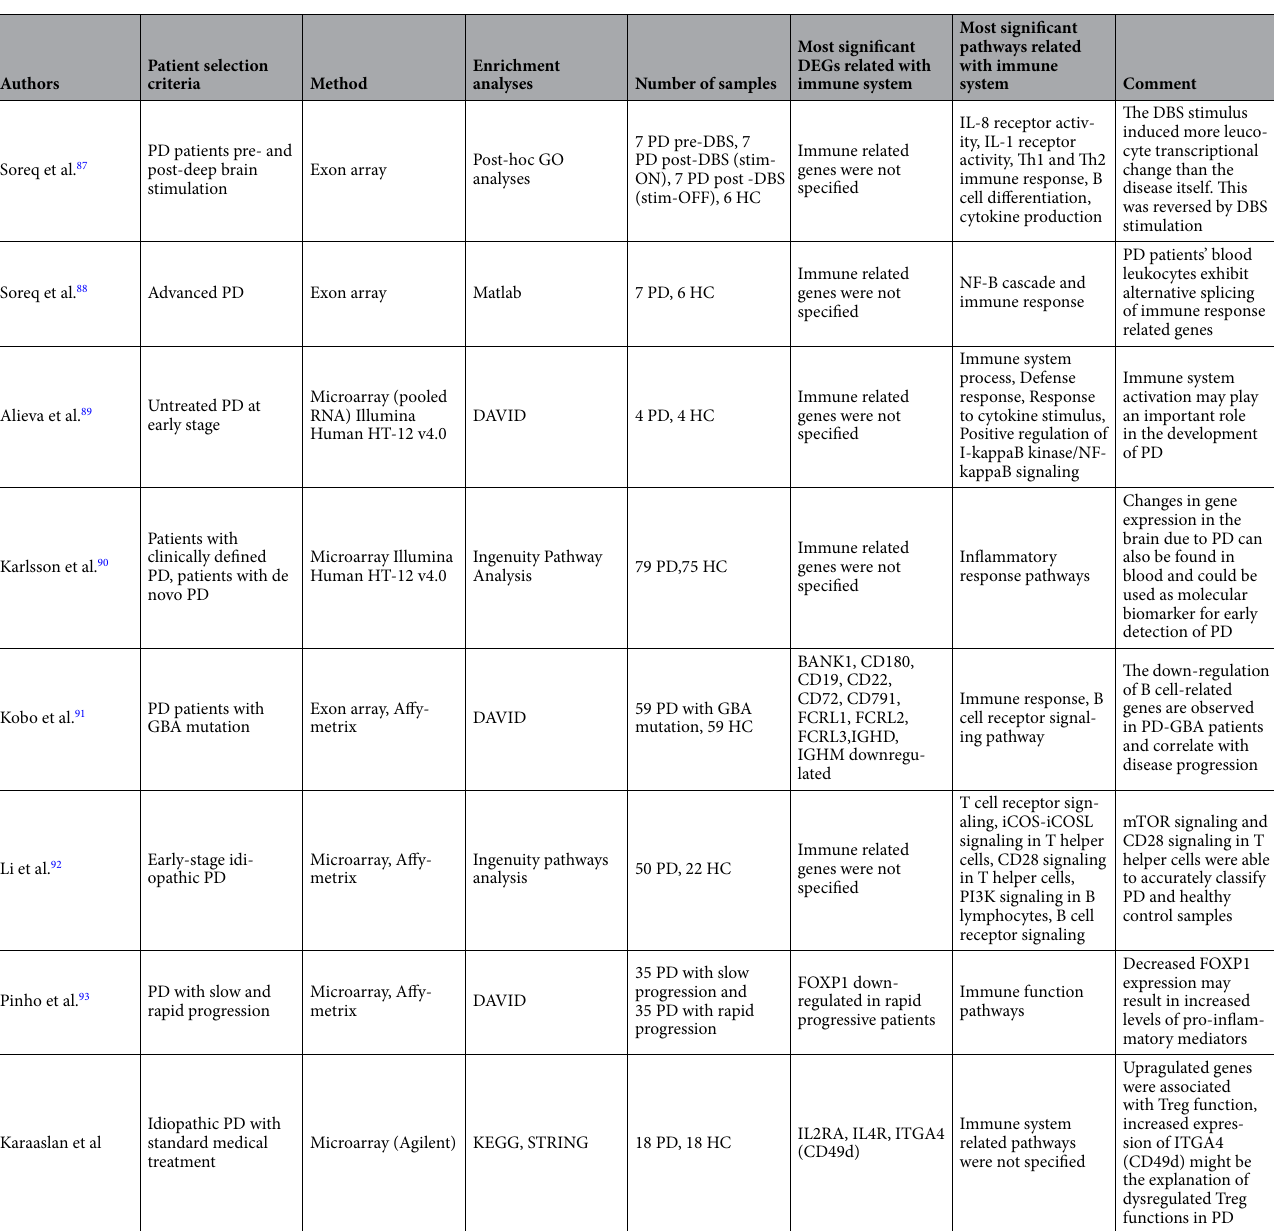
Table 7. Comparison of the recently performed peripheral blood transcriptome studies of PD patients with our study. PD Parkinson’s disease, HC healthy control, NC neurological control, BINGO biological networks gene oncology, KEGG Kyoto Encyclopedia of Genes and Genomes, DAVI : database for annotation, visualization and integrated discovery, STRING search tool for the retrieval of interacting genes/proteins, GO gene ontology, GBA glucosidase beta